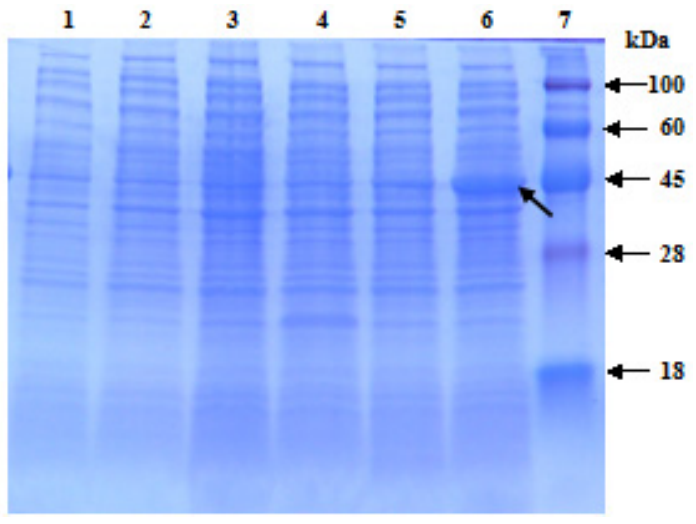
Figure 6. The prokaryotic expression of pET 32a- ScChi in Escherichia coli Rosetta